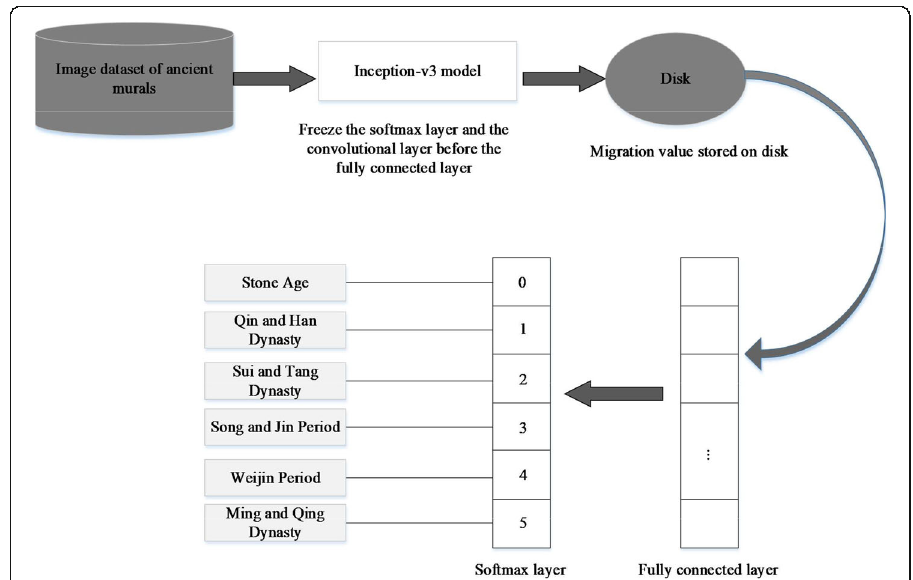
Fig. 2 Dynasty-based classification model for ancient